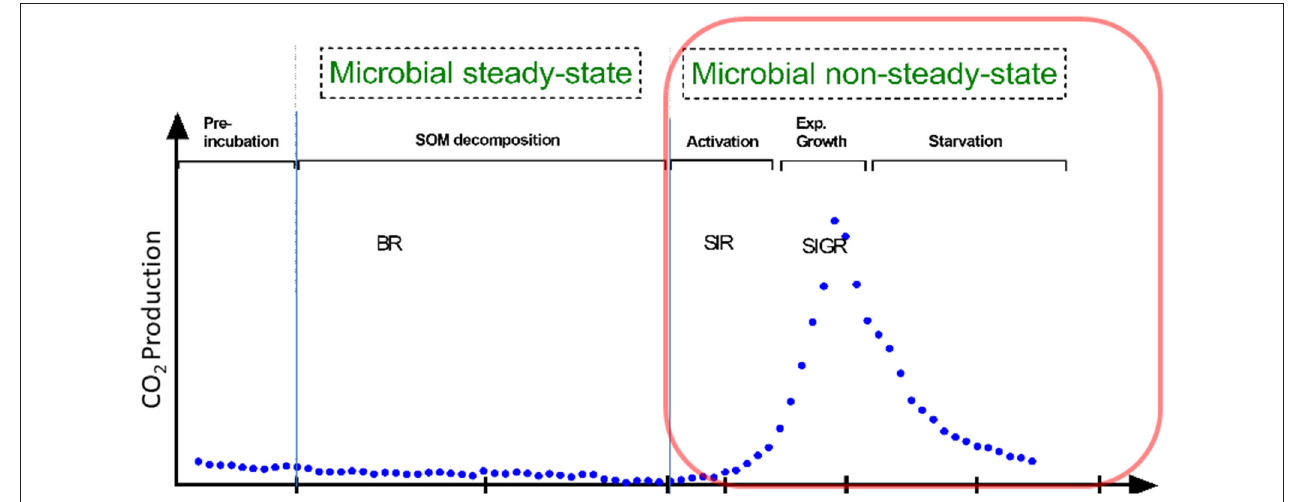
FIGURE 1 | Conceptional soil microbial respiration: We focused on microbial non-steady state condition, reflecting the phases of microbial growth (lag, exponential growth). This is in contrast to the basal respiration (BR) without any additional substrate addition. Soil activation leads to increased protein synthesis in the early exponential phase; protein for motility occurs mainly at mid-exponential phase; in the late expontential phase typically accounts for stress resistance, since substratre gets scarce; stationary phase reflects stable to slight decreasing microbial biomass. Substrate-induced respiration (SIR) and substrate-induced growth respiration (SIGR) are commonly used to determine microbial growth parameter and microbial